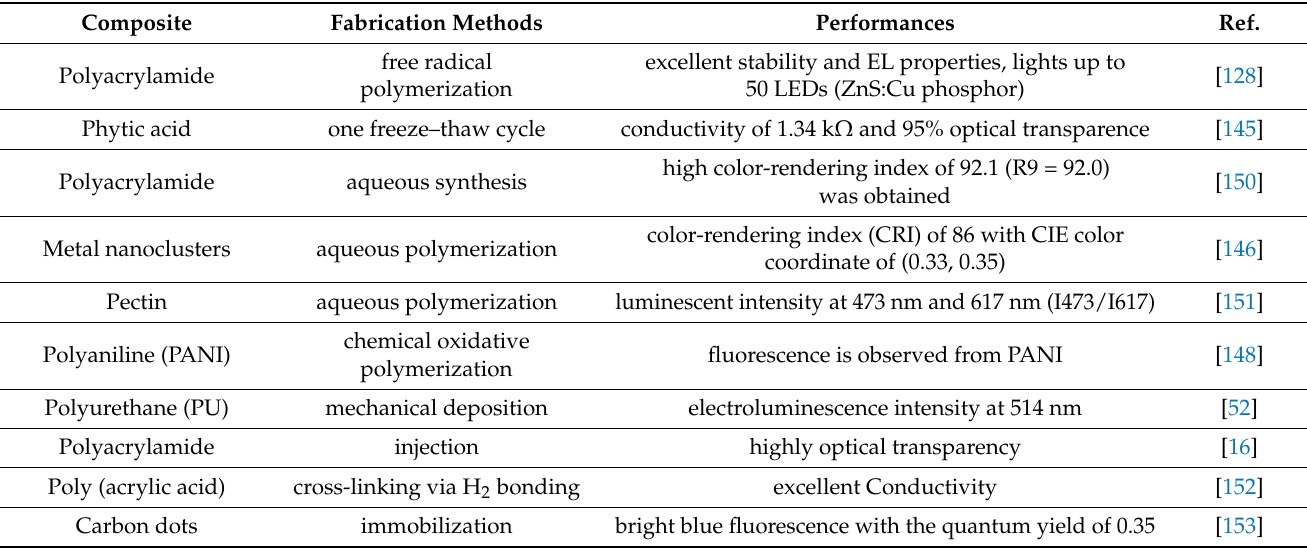
Table 2. Comparison of PVA-based hydrogel materials for electroluminescence